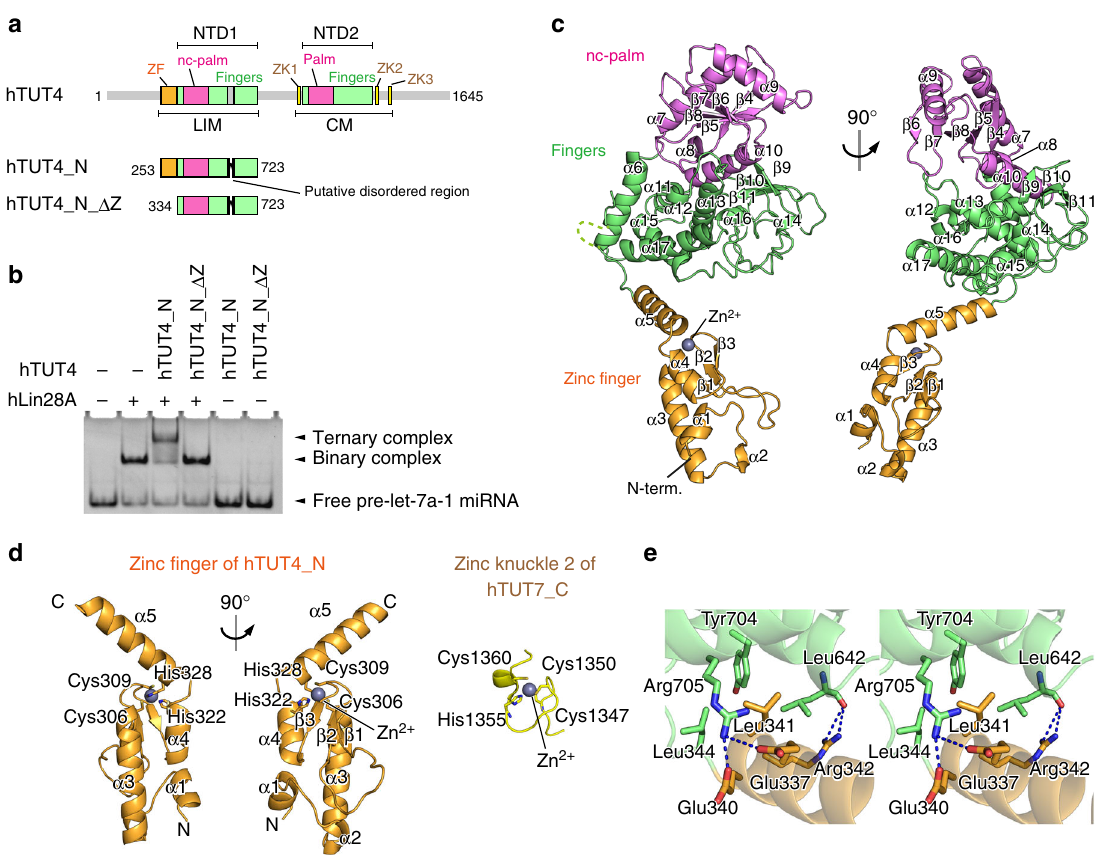
Fig. 1 Structure of the Lin28-interacting module of human TUT4. a Schematic diagrams of human hTUT4, hTUT4_N, and hTUT4_N_ Δ Z. The zinc fi nger (ZF), the palm, the fi ngers, and the zinc knuckles (ZK1 – 3) are colored orange, magenta, green, and yellow, respectively. b Gel retardation assays with recombinant hLin28A, hTUT4_N, and hTUT4N_ Δ Z in the presence or absence of hLin28A. hTUT4_N, but not hTUT4_N_ Δ Z, forms a ternary complex with pre-let-7a-1 and hLin28A. c Overall structure of human hTUT4_N, containing the Lin28-interacting module (LIM). The zinc fi nger (ZF), the non-catalytic palm (nc-palm), and the fi ngers are colored orange, magenta, and green, respectively, as in a . Residues 712 – 719 are represented by a dashed line. d Comparison of the structures of the N-terminal ZF of human TUT4 (left) and the C-terminal zinc knuckle of human TUT7 23 (right, PDB ID: 5W0N). e A detailed view of the interactions between the ZF (orange) and the fi ngers (green). Hydrogen bonds are depicted by dashed